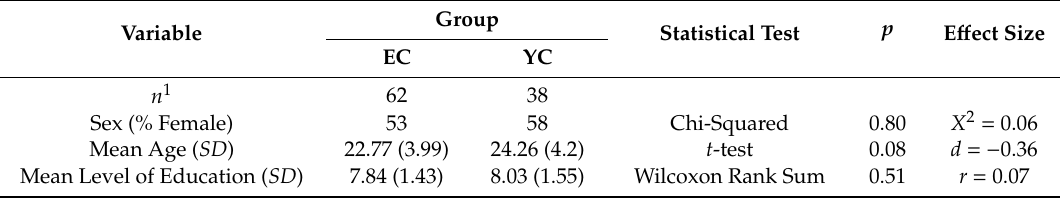
Table 2. A priori group comparisons in study